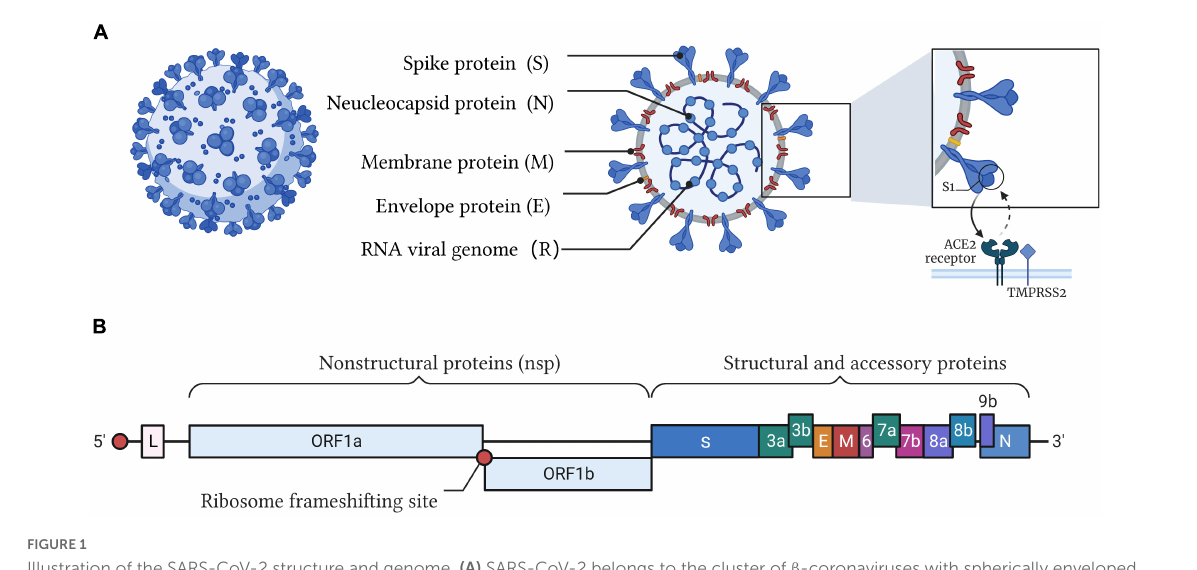
FIGURE1 Illustration of the SARS-CoV-2 structure and genome. (A) SARS-CoV-2 belongs to the cluster of β -coronaviruses with spherically enveloped virions. Envelope glycoproteins such as spike protein (S), envelope protein (E), and membrane protein (M) are embedded in a lipid bilayer envelope. Nucleocapsid protein (N) coupled with single-stranded positive-sense viral RNA is inside the envelope. Through the interaction between the receptor-binding domain (RBD) of the spike protein and angiotensin converting enzyme 2 (ACE2), SARS-CoV-2 invades host cells. (B) The genome of SARS-CoV-2 encodes four major structural proteins (S, E, M, N), 16 non-structural proteins (nsp), and 8 accessory